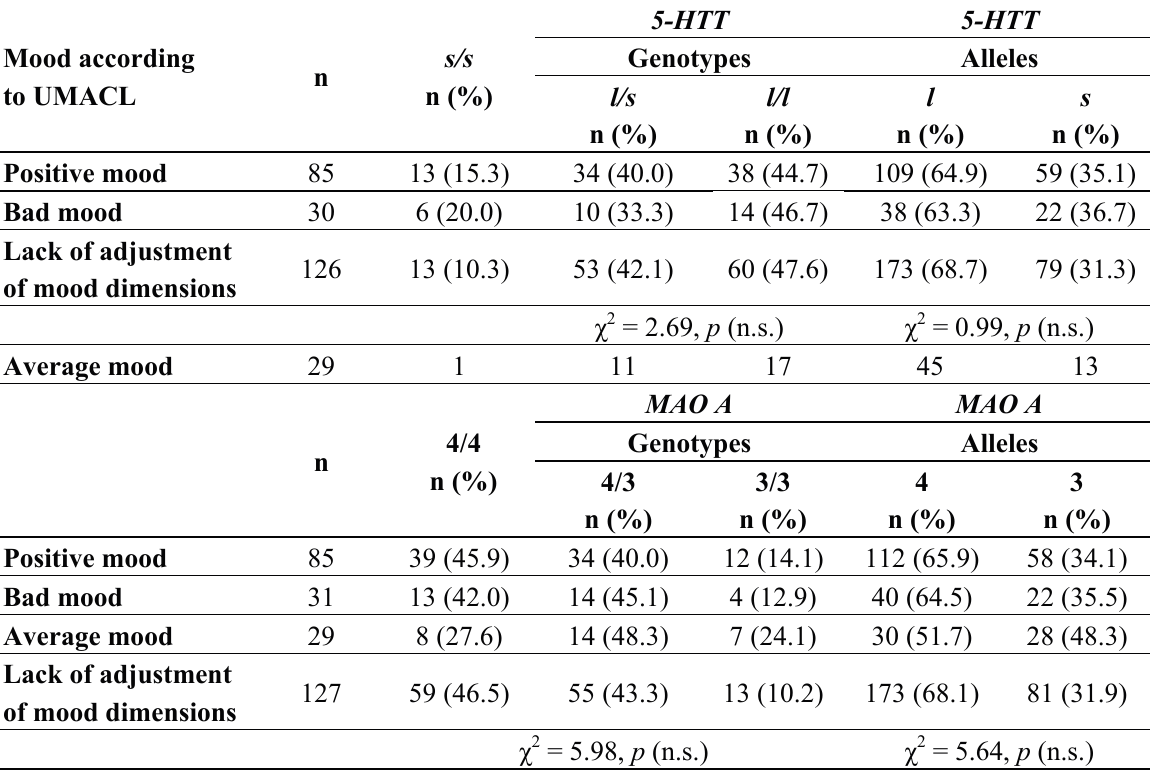
Table 4. Distribution of genotypes and alleles frequency of the 5-HTTLPR (SLC6A4) polymorphism and the 30-bp VNTR polymorphism in the MAO A promoter region and mood state according to UMACL among the women